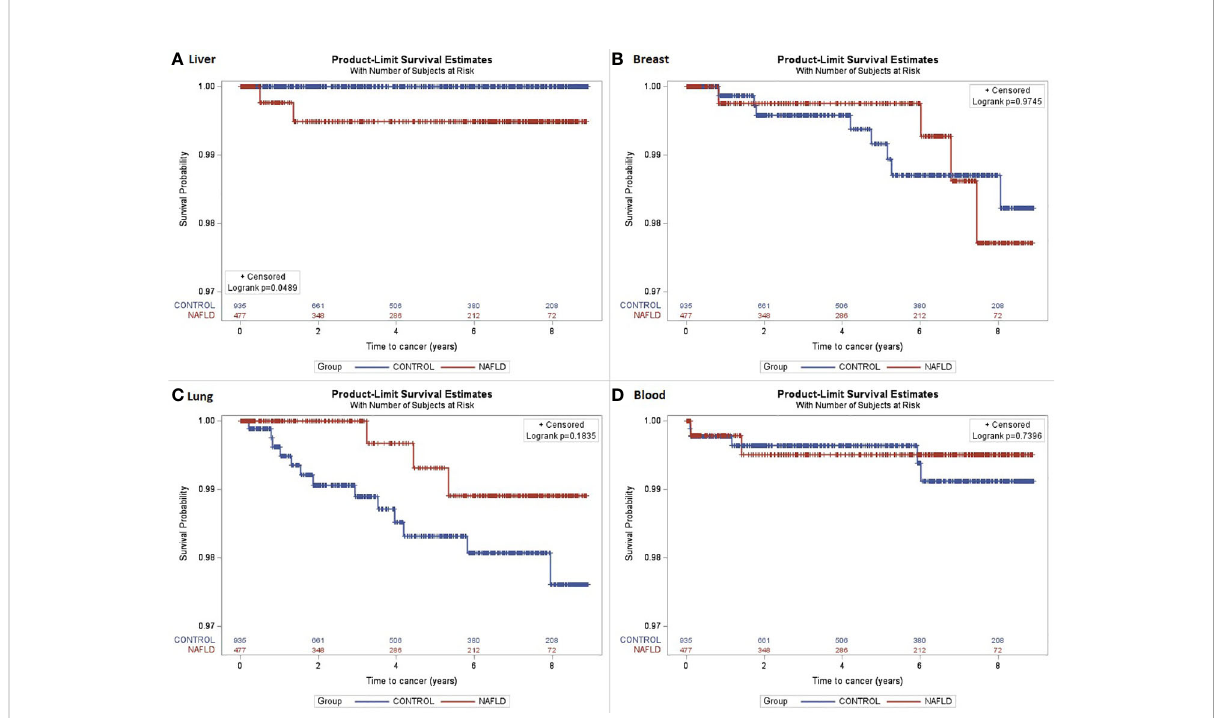
FIGURE 1 The Kaplan – Meier curves were estimated for cancer survival. (A) Liver cancer survival (log-rank p = 0.0489); (B) Breast cancer survival (log-rank p = 0.9745); (C) Lung cancer survival (log-rank p = 0.1835); (D) Blood/bone marrow cancer survival (log-rank p =